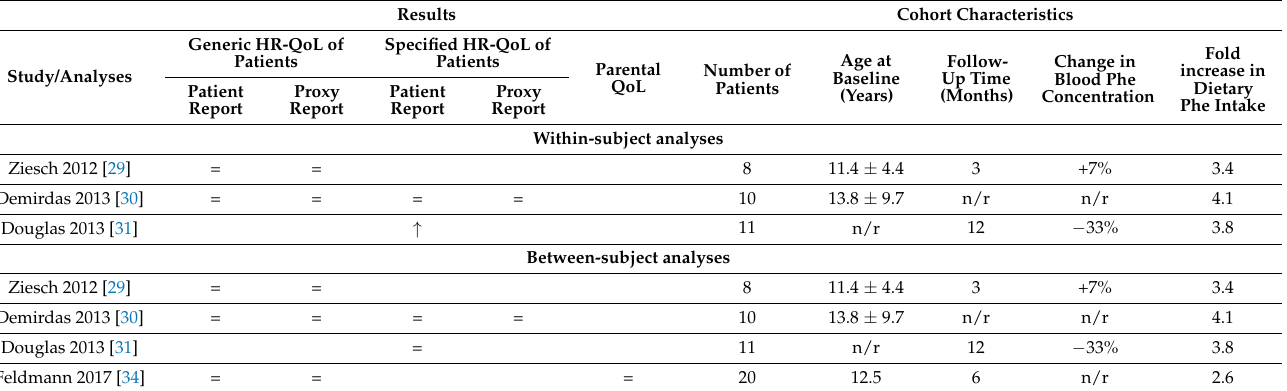
Table 5. Results of within-subject (baseline versus last point of follow-up during BH 4 treatment) and between-subject (BH 4 -treated group versus control group at last point of follow-up) analyses for total scores of quality of life questionnaires. Cohort characteristics are taken from Table 2. =, no significant change (within-subject analyses) of no significant difference (between-subject analyses); ↑ , significant increase or significantly higher in BH 4 -treated group (if not already significantly higher at baseline). N/r, not